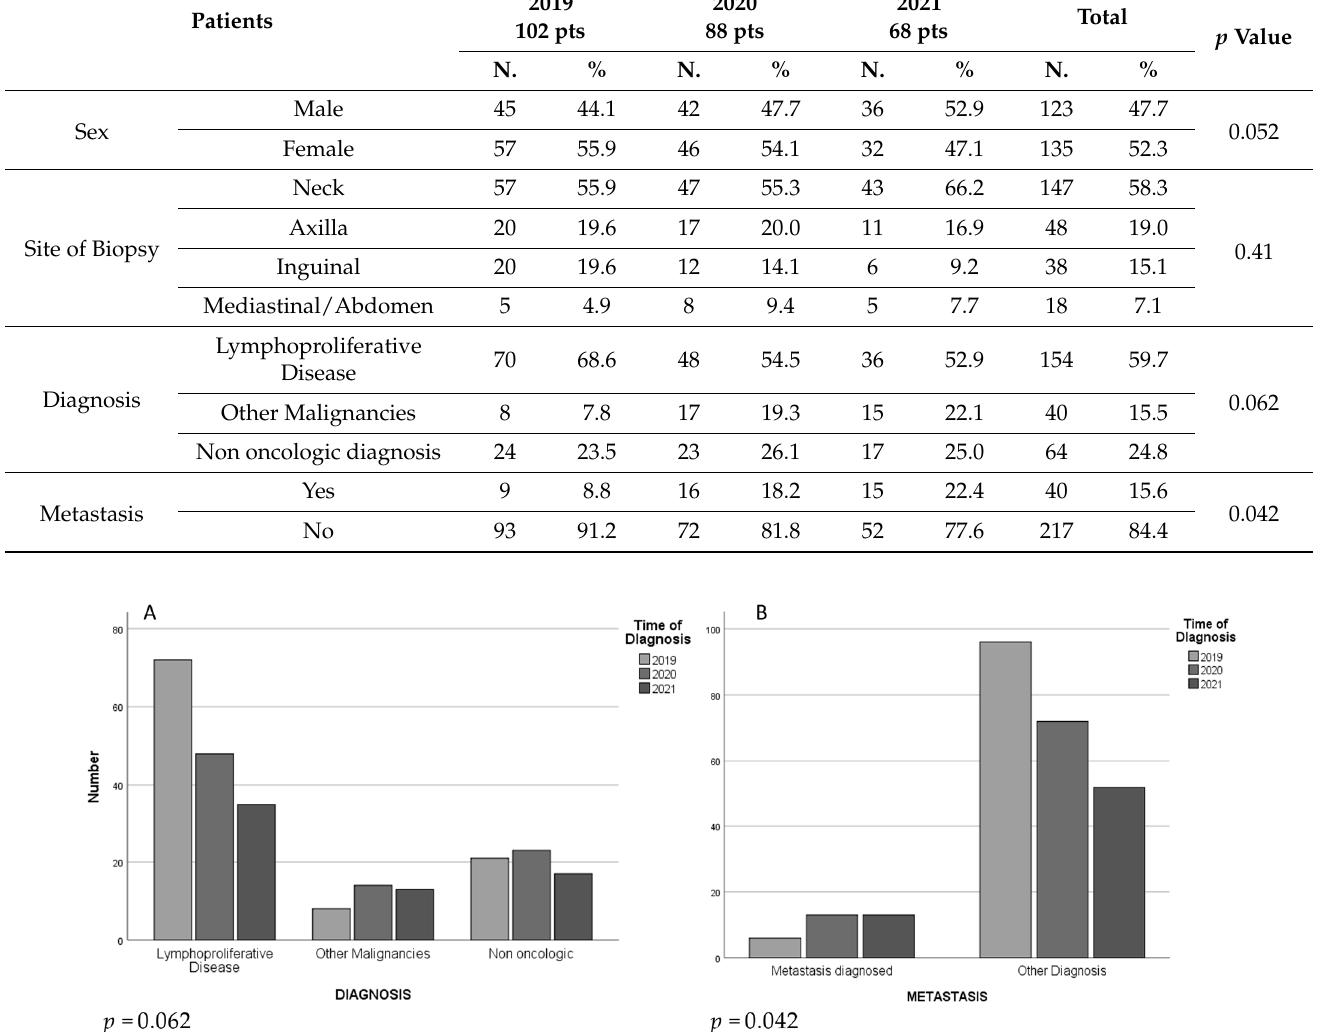
Table 1. Patients’ data. This table shows cohort characteristics, highlighting sex, site of biopsy, diagnosis, and metastasis. Univariate analysis was performed with an χ 2 -test, and p values are reported on the right side.